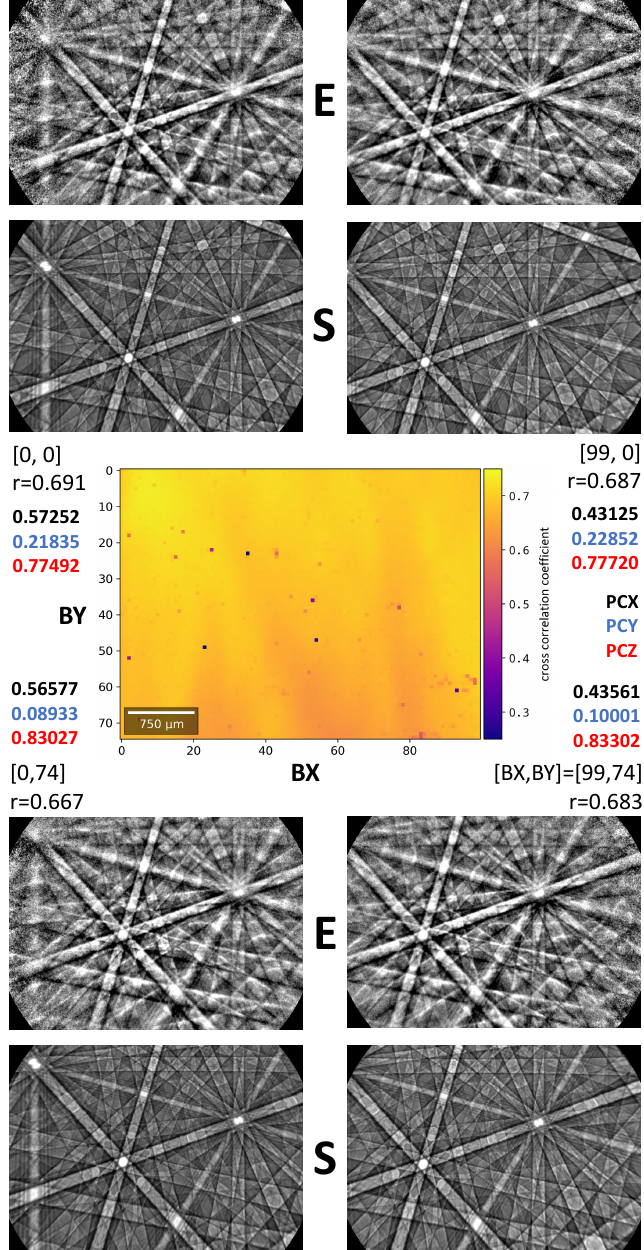
Figure 2. Projection center (PC) pattern matching results for the corner points of the map. The experimental patterns are marked by “E” and the corresponding best-fit simulations are shown by “S”. The best-fit PC values PCX , PZY , PCZ are shown in color, below the beam scan indices [ BX , BY ] and the value of the normalized cross-correlation coefficient r . In agreement with the geometry of the scan relative to the EBSD screen [4], the Kikuchi patterns can be seen to move to the left with increasing BX , and upwards with increasing BY . Because the vertical movement with increasing BY also moves the beam away from the screen on the tilted sample, increasing PCZ, the patterns in the lower row also appear magnified, as can be seen by the slightly broader Kikuchi bands. The full map of r -values resulting during the final orientation refinement shown in the